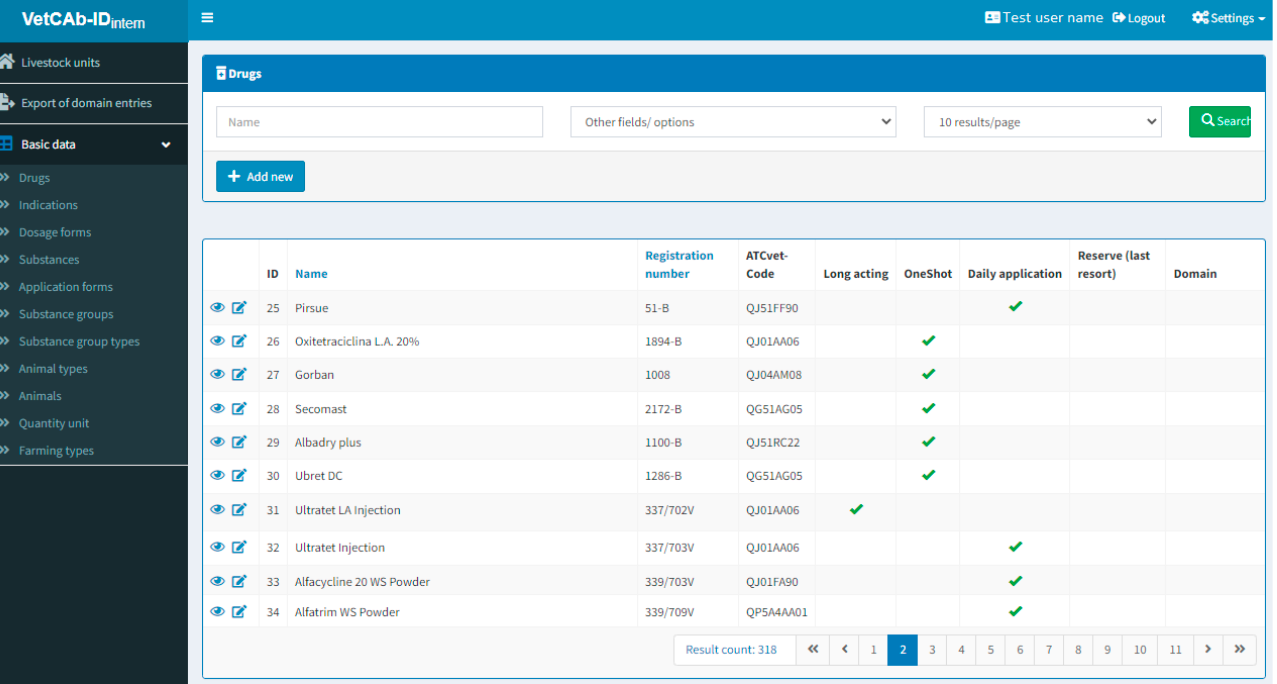
Figure 3. Drugs entered and available for several domains (anonymized). The dropdown menu “Basic data” is opened. For each of the options in the dropdown list, a set of predefined entries is provided to users.